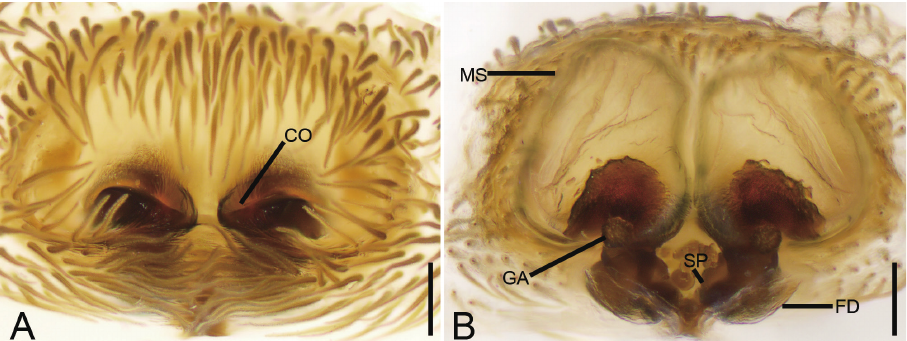
Figure 13. Stephanopis xiangzhouica sp. nov., female epigyne, holotype. A ventral view B dorsal view. Abbreviations: CO – copulatory opening, FD – fertilisation duct, GA – glandular appendage, MS – mem- branous sac, SP – spermatheca. Scale bars: 0.1